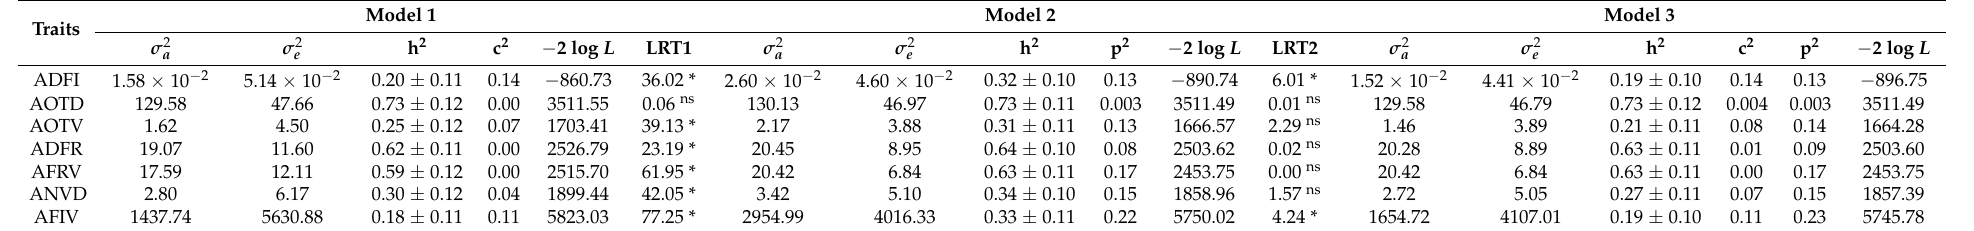
Table 3. Heritability estimates and variance components for feeding pattern traits of Duroc